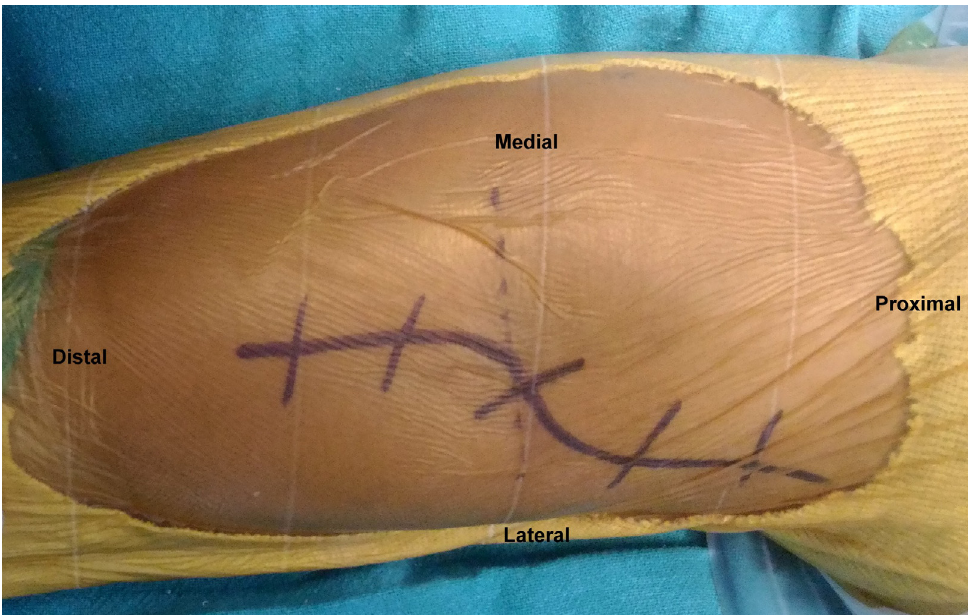
Figure 4. The curved S shaped skin incision.